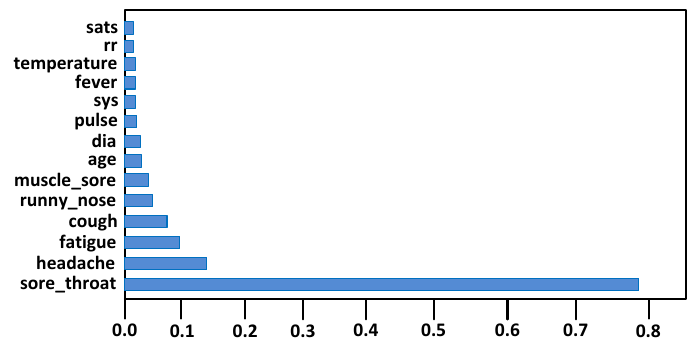
Figure 6. Extracted